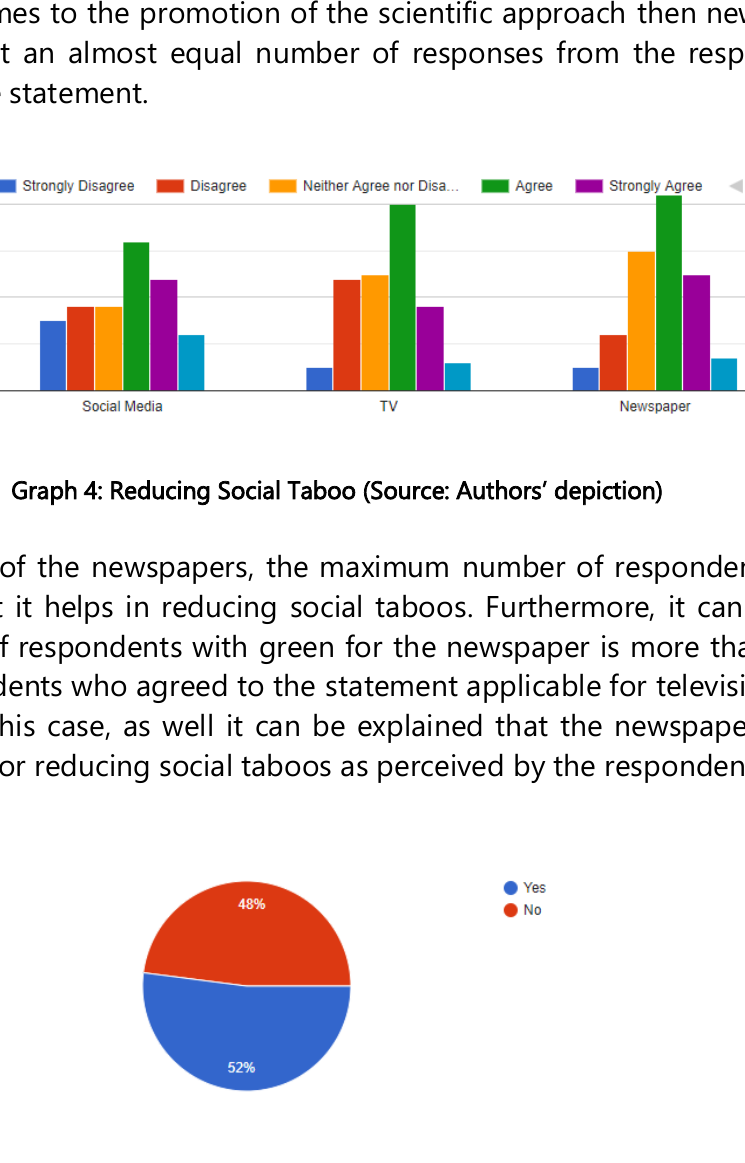
Graph 5: The Element of Fear Promoted By Negative Representation of News (Source: Authors‟